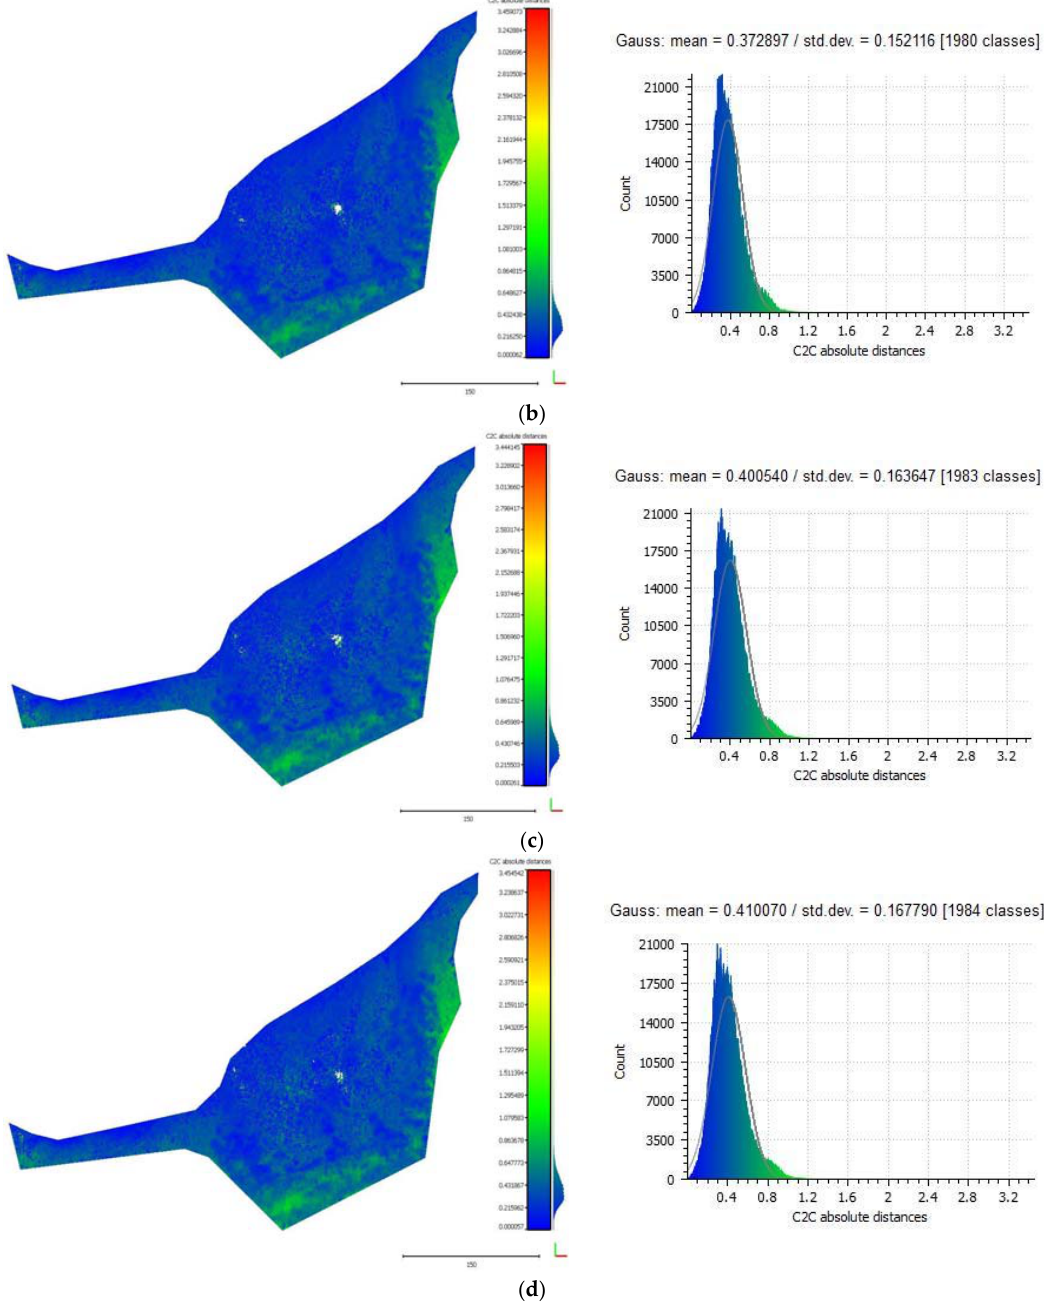
Figure 15. The cloud ‐ to ‐ cloud distances between the initial point cloud and the point clouds that resulted at each iteration of the algorithm on the Amathouda test site. Row ( a ) presents the cloud ‐ to ‐ cloud distances between the original point cloud and the point cloud that resulted from the first iteration of the algorithm and their respective histogram. Rows ( b – d ) present the cloud ‐ to ‐ cloud distances between the initial point cloud and the point cloud that resulted from the second, third and fourth iteration of the algorithm, respectively.